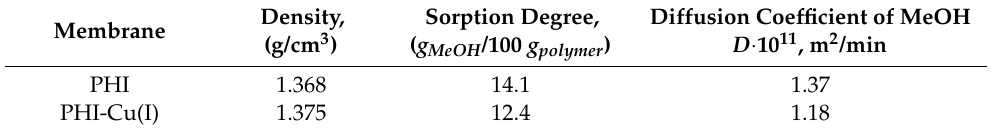
Table 4. Physical properties of the